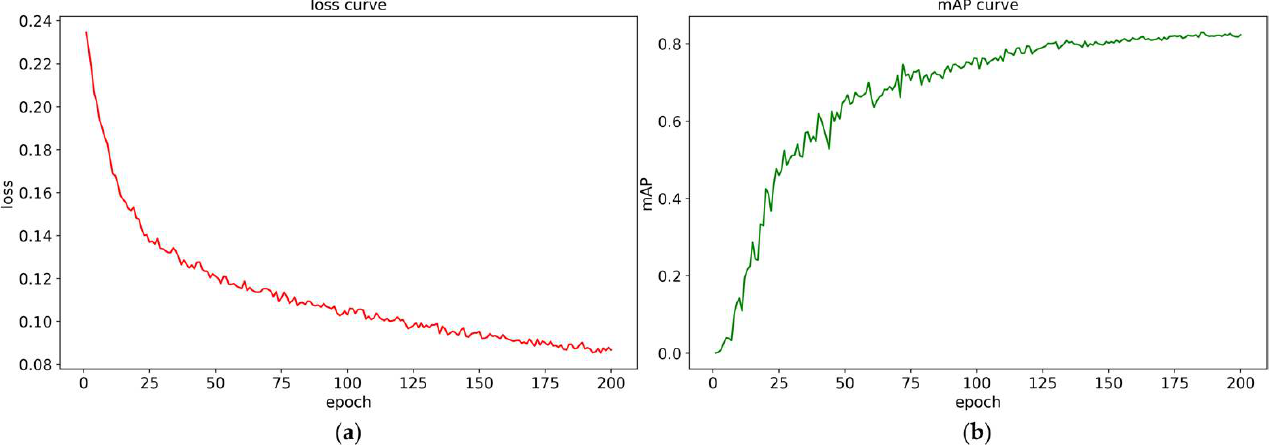
Table 3. The degree of matching and the distribution range of the prior